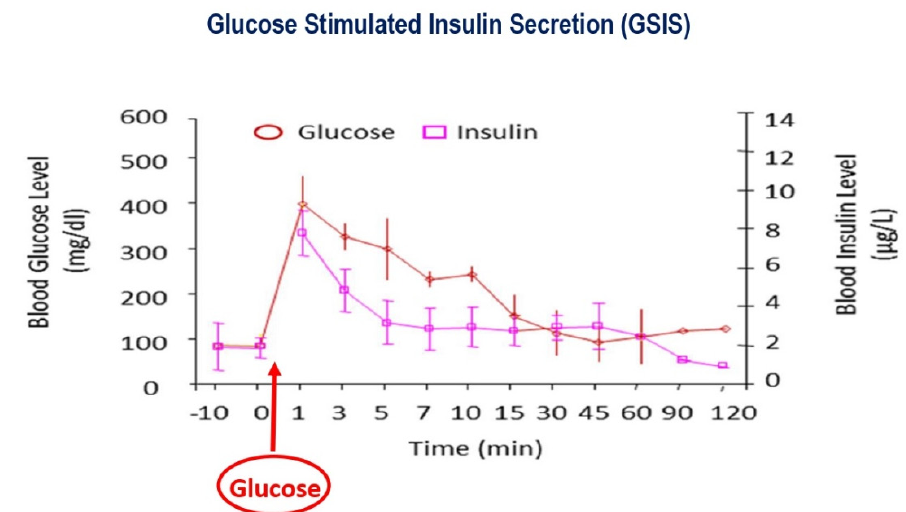
Figure 3. Glucose depends on insulin to enter the peripheral tissues, muscles, and fat. Without insulin, glucose stays in the blood, causing diabetes. The increase in blood glucose concentration triggers insulin secretion. Blood glucose levels, brown graph; the increase in blood glucose level triggers a prompt and parallel increase in insulin secretion, pink graph. With time, blood glucose levels reduce due to insulin’s facilitated entry into fat and muscles. In accord, reducing blood glucose levels is paralleled by lowering insulin